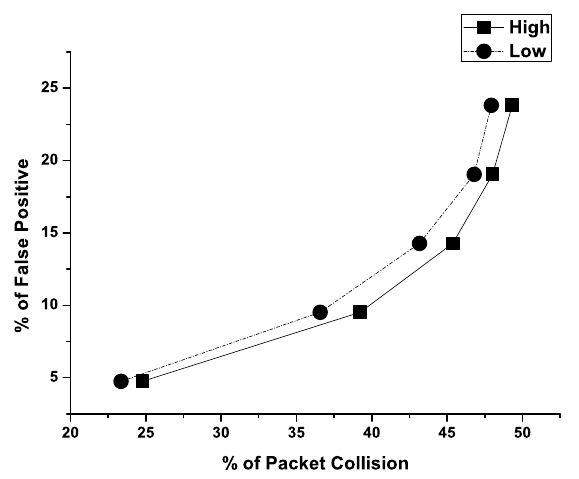
Figure 4. False positive vs. packet collision.